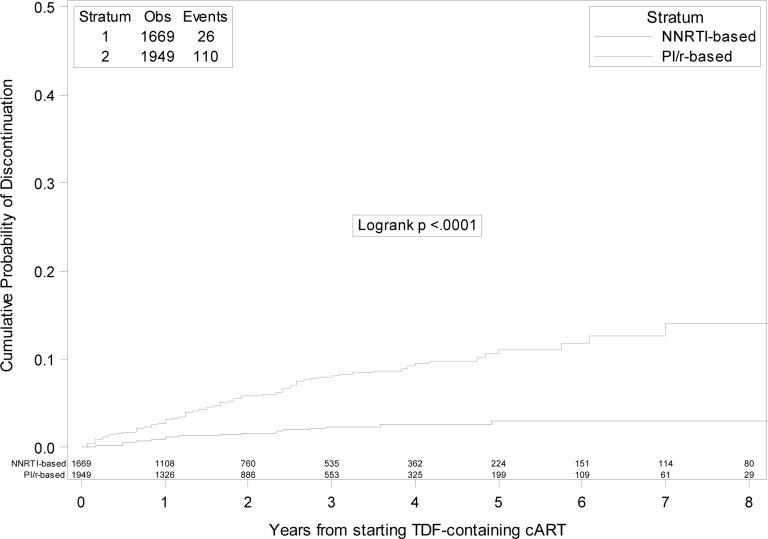
Kaplan-Meier estimates of risk of selective tenofovir discontinuation in boosted protease inhibitors versus non-nucleoside reverse transcriptase inhibitors groups.